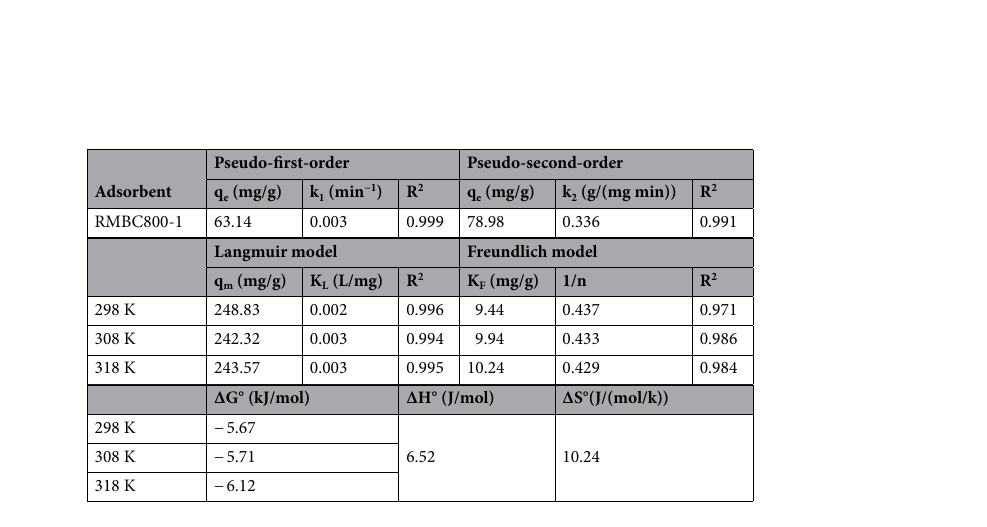
Table 1. Quasi-first-order and quasi-second-order kinetic model, isothermal and thermodynamics fitting parameters of IMC for Cr(VI) adsorption.